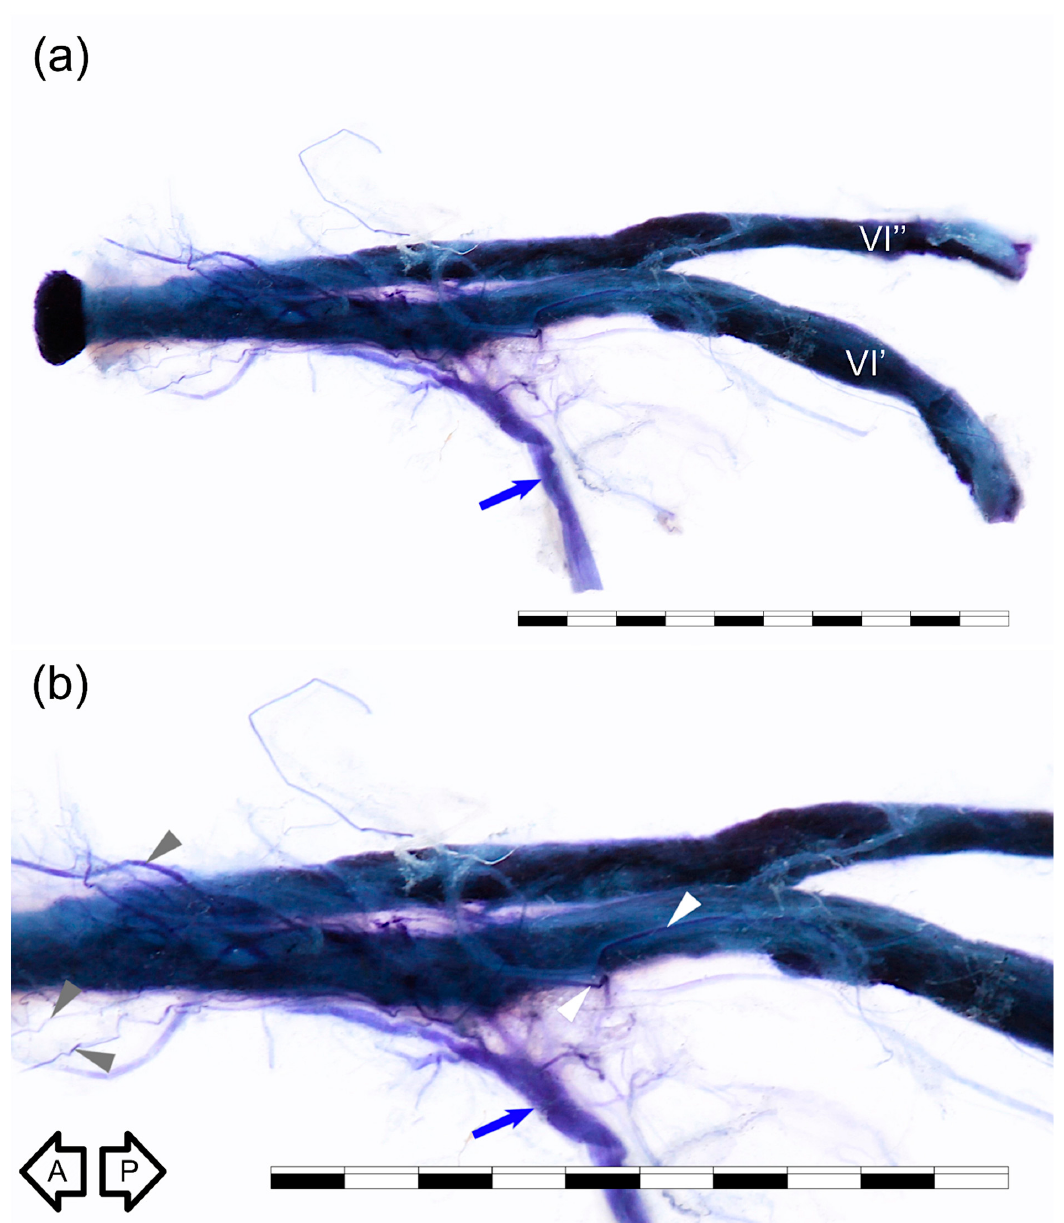
Figure 3. Duplication of the AN. Medial view of the right nerve. Sihler’s stain. Two nerve trunks (VI’ and VI”) merge. ( a ) General view. ( b ) Photograph enlarged to visualize better nerve fiber bundles derived from the internal carotid plexus that accompany the AN. Blue arrow marks a well-developed anterior bundle of the sympathetic nerve fibers joining the inferior aspect of the nerve. Some of those fibers accompany the AN to join the cavernous sinus lateral wall (white arrowheads), while some of the fibers continue with the AN anteriorly (gray arrowheads). Black arrows indicate directions: A—anterior; P—posterior. Scale bar corresponds to 10 mm.